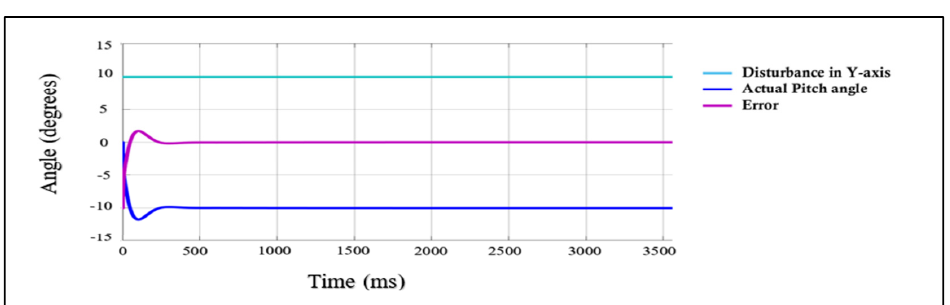
B. under tilt angle -10° on negative Y-axis. Fig. 12. Self-balancing behavior of simulated model on Y-axis.